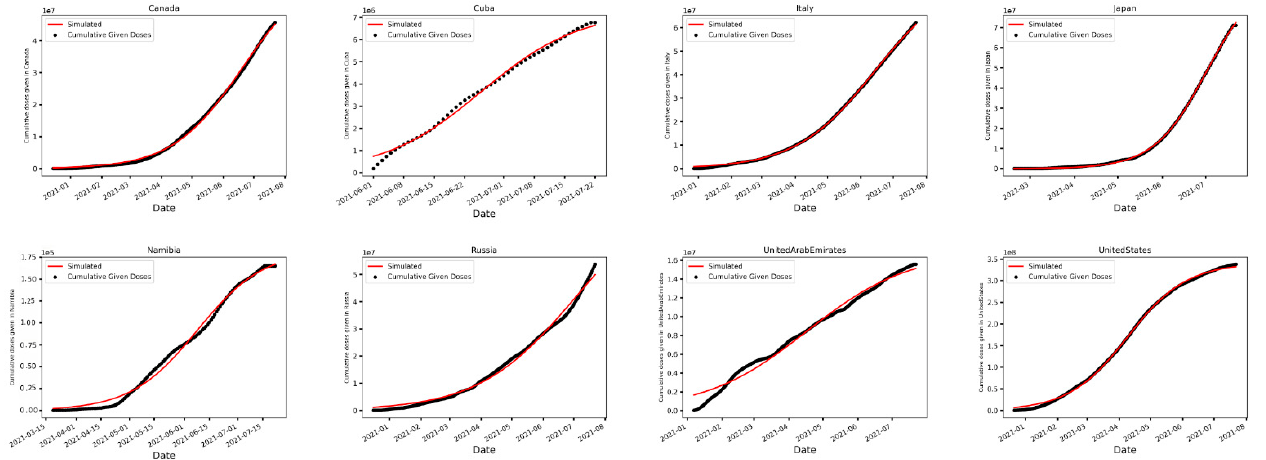
Figure 1. Dots represent cumulative given doses, and curves are fitted based on the logistic growth model. Countries are sorted alphabetically. Here, only some select countries are shown. The average of R 2 across all countries is 0.99.